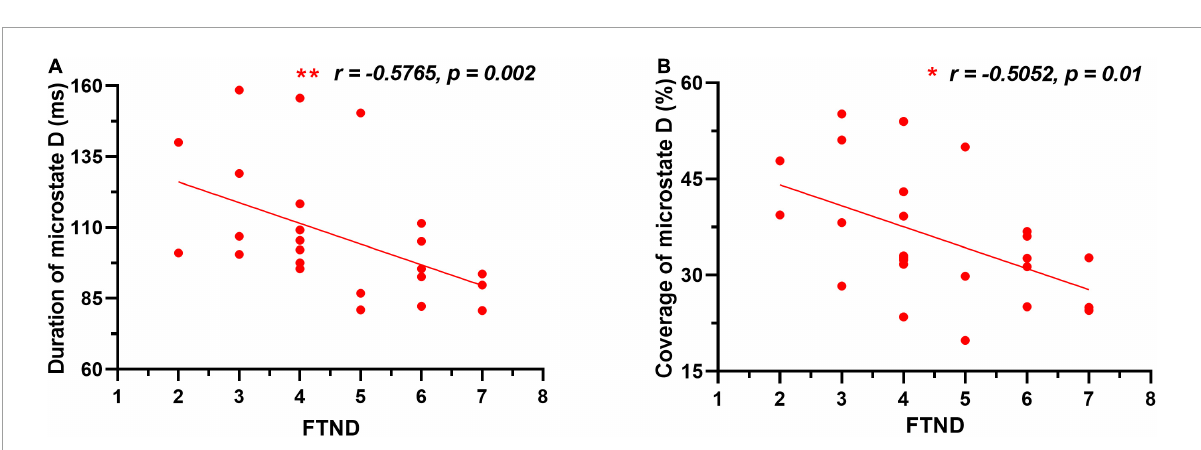
FIGURE2 Correlations between microstate features and smoking characteristics of young smokers. (A) The duration of microstate D was significantly negatively correlated with FTND in young smokers. (B) The coverage of microstate D in young smokers was significantly negatively correlated with